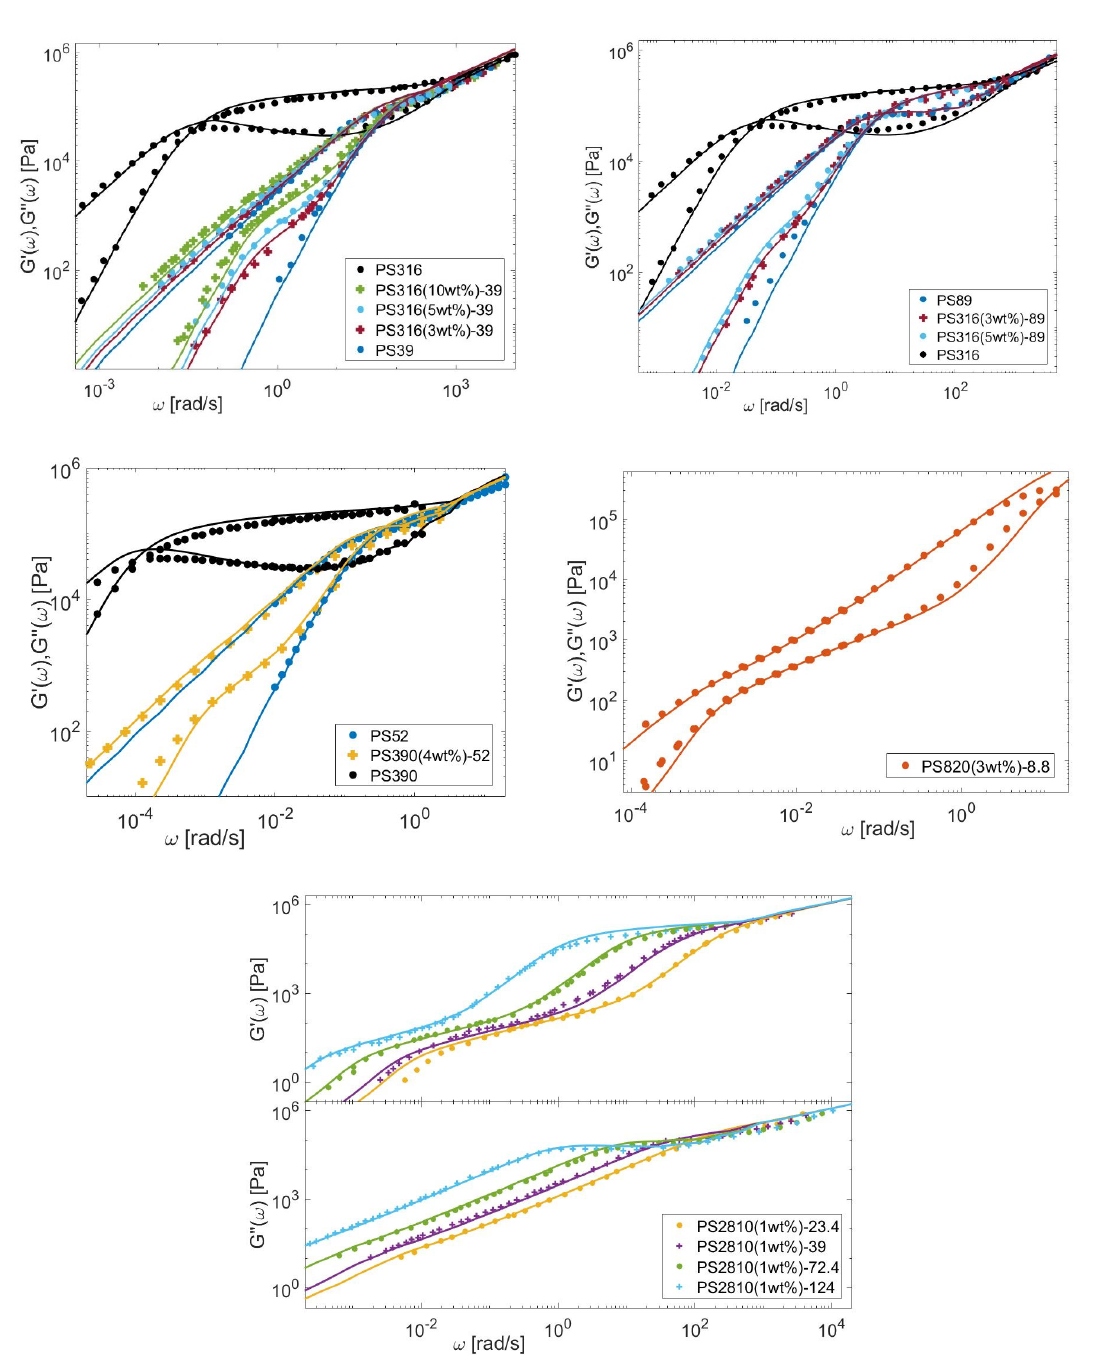
Figure 13. Comparison between predicted (continuous lines) and experimental (symbols) storage and loss moduli of the long PS chains in monodisperse state or diluted in various matrices (see Table 3).